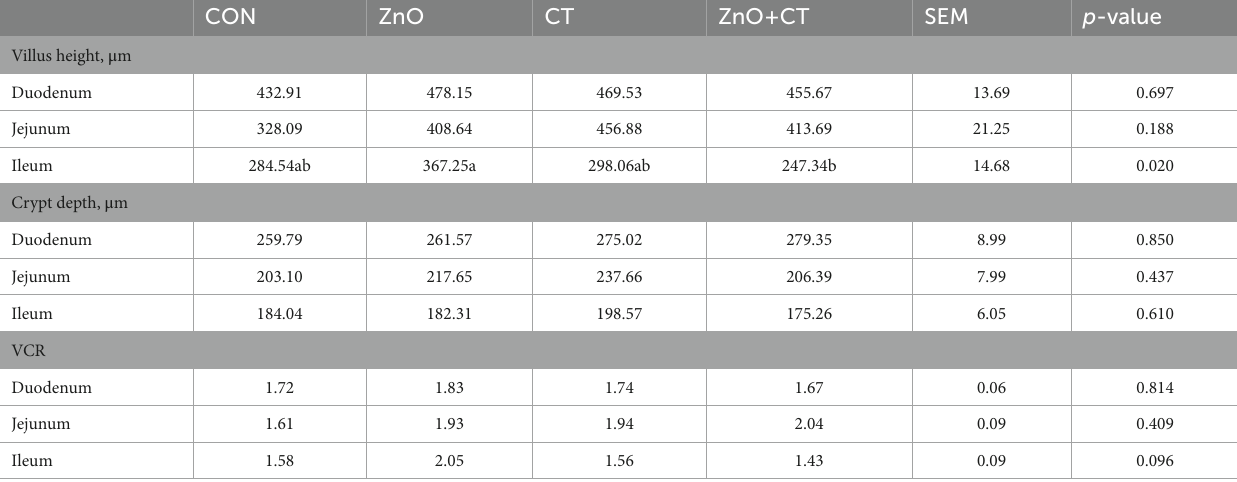
TABLE 3 Effects of ZnO and CT on intestinal morphology of weaned piglets in K88-challenged environment. CON ZnO CT ZnO + CT SEM p